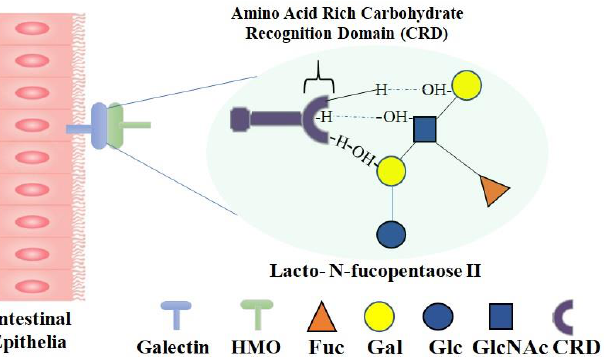
Figure 4. Galectin–HMO Binding. Human milk oligosaccharides bind to galectin expressed by intestinal epithelia; zoom-in image of gelectin-HMO binding site shows the detailed molecular representation of chemical interactions: OH groups of galactose and N-acetylglucosamine in HMOs form hydrogen bonds with amino acid residues (e.g., His44, Arg48, Trp68, Val59, Asn61, Asn46, Glu71, and Arg73) in the CRD region of galectin.